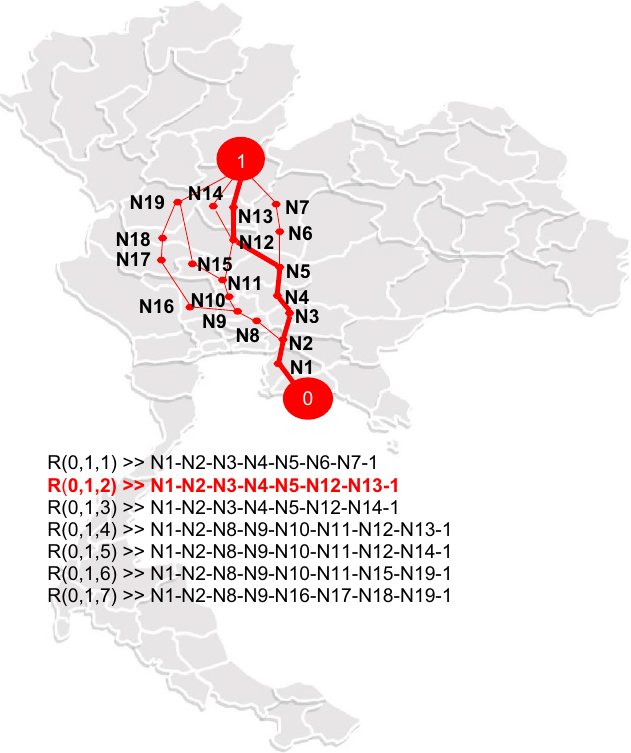
Figure 4. BSF route from Rayong (0) to Phitsanulok-storage area (1) with the highest D on Thailand map made with Microsoft Office 365, Excel Version 1905 (https:// www. office. com/ launch/ excel? auth=2).